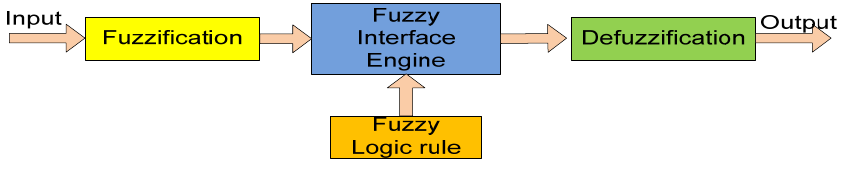
Figure 6. Basic fuzzy logic controller model .